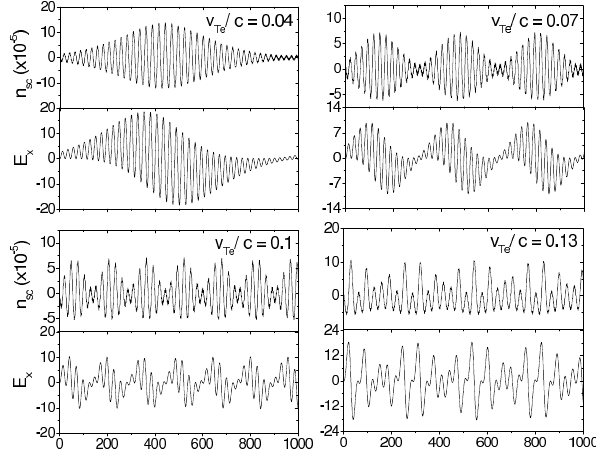
/c on LH- e /c =0.1 is the typical e